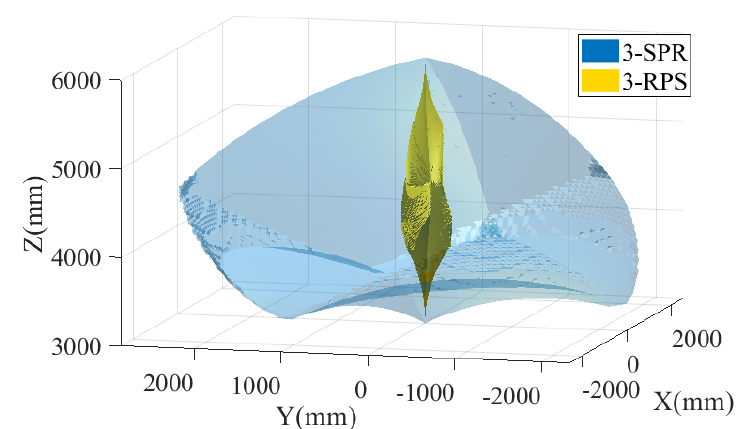
Figure 10. Position workspace comparison of two platforms.